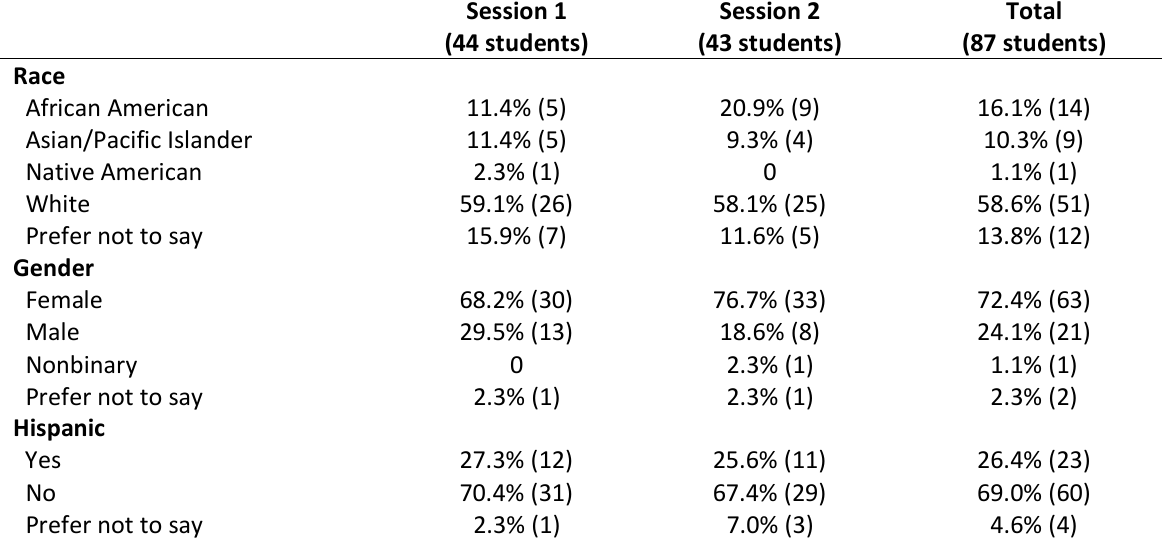
Table 1. Race, gender, and ethnicity of